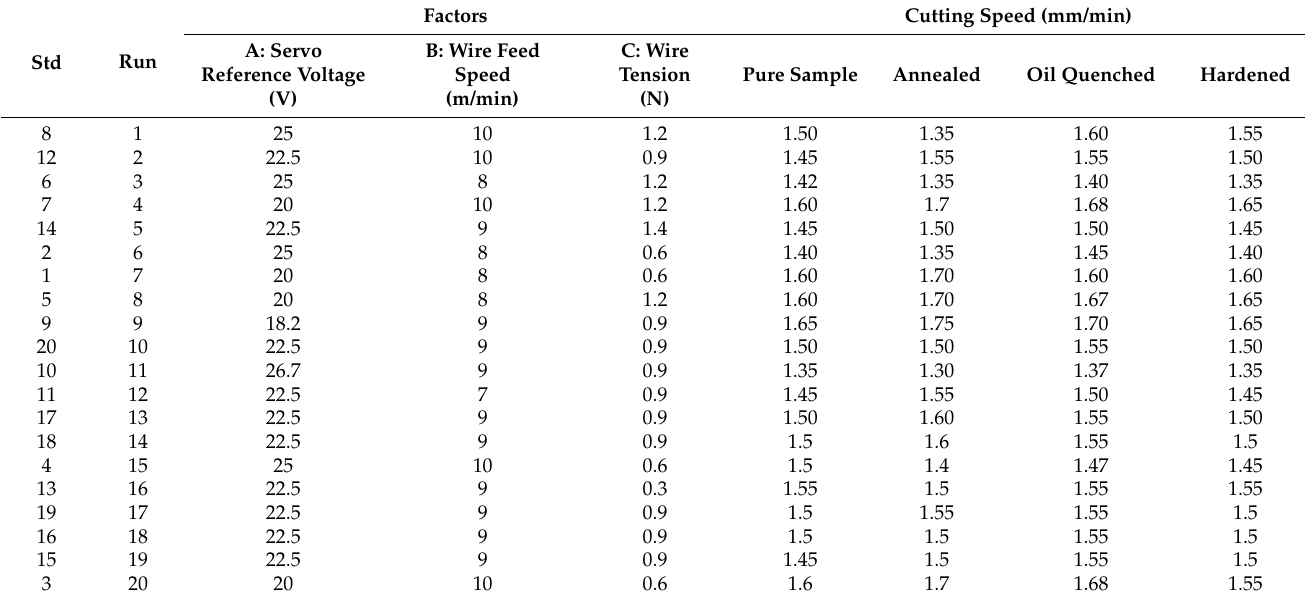
Table 4. Experimental design according to the